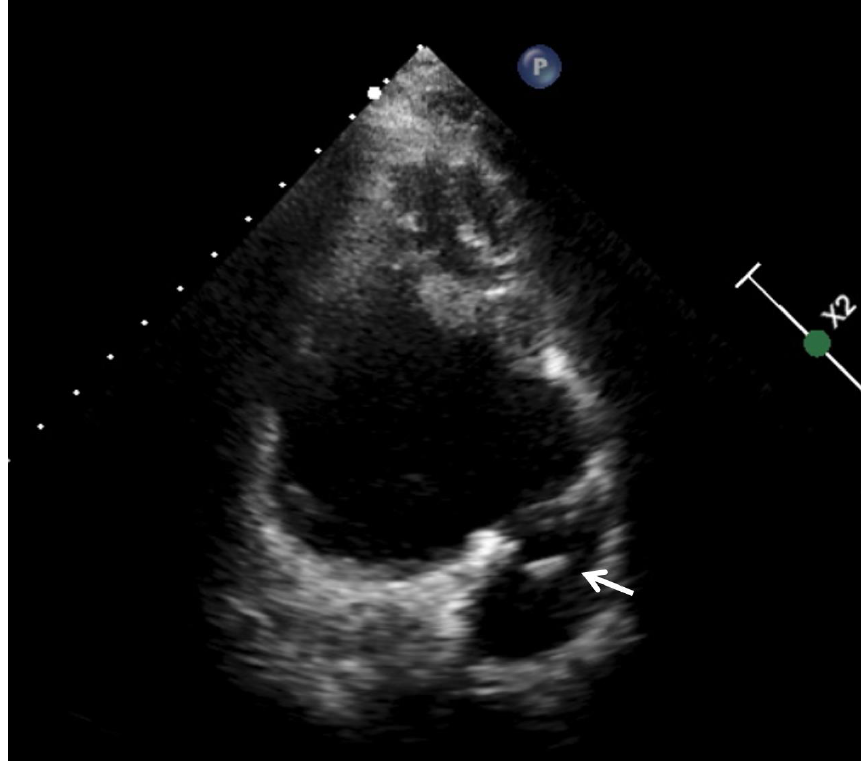
Figure 2. A 16-year-old woman with tetralogy of Fallot and pulmonary atresia. Contegra conduit endocarditis by Streptococcus sanguis.